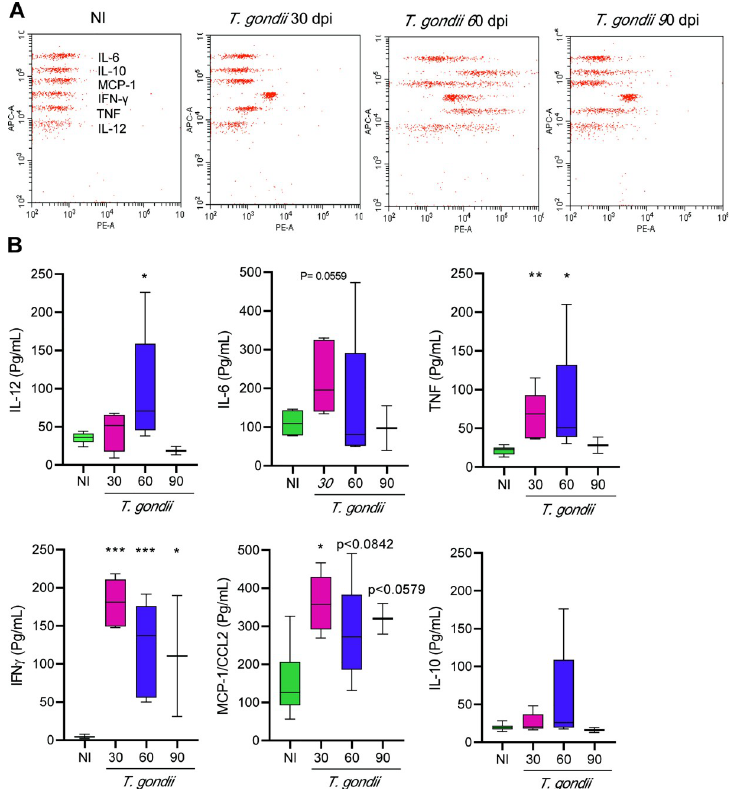
Fig 9. Systemic cytokine expression is upregulated in the early and long-term chronic Toxoplasma gondii infection. ( A ) The images show representative data plots of the FACS analysis of CBA. ( B ) Chronically T . gondii - infected mice showed increased levels of pro-inflammatory cytokines at 30 and 60 dpi. At 90 dpi, all cytokine levels showed a tendency to decrease or, even, exhibited cytokines levels like those found in sera of NI controls, except for IFN γ and MCP-1/CCL2 levels. Each experimental group consisted of 2–3 NI mice and 2–5 T . gondii -infected mice, in two independent experiments. Data are expressed as means ± SEM, and were analyzed using ordinary one-way ANOVA. � , p < 0,05, �� , p < 0.01. ��� , p < 0.001, comparing T . gondii- infected and NI